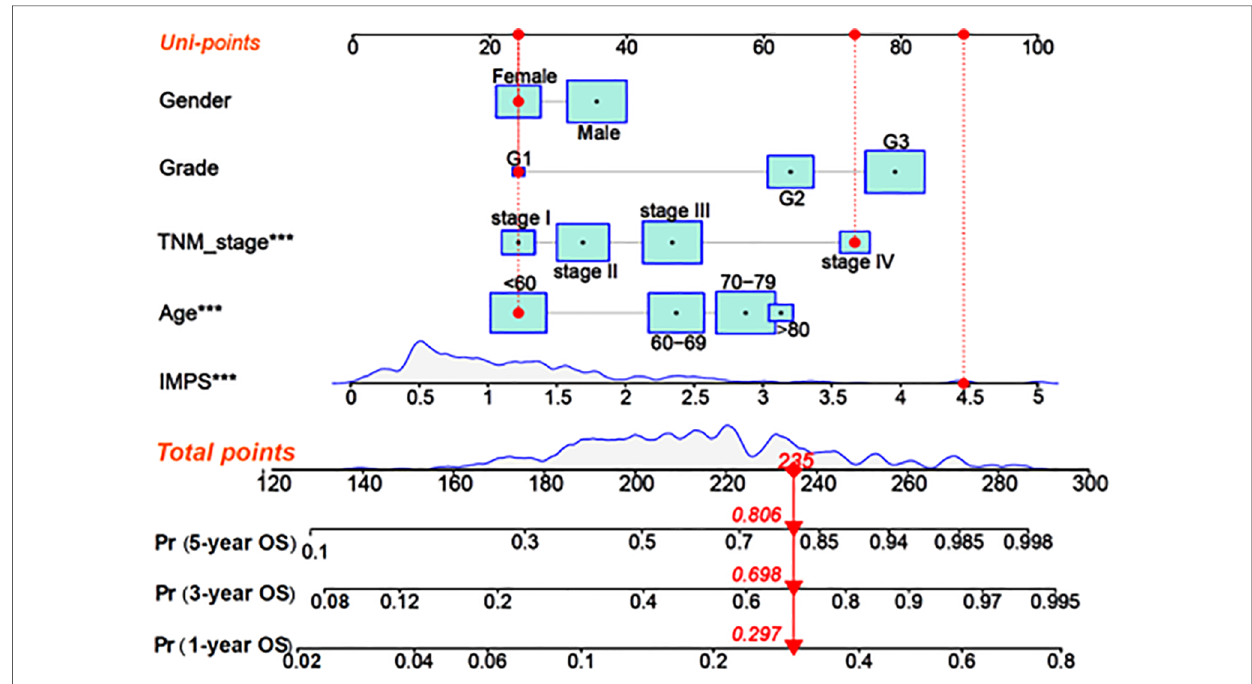
FIGURE 8 Construction of the combined nomogram based on IMPS and clinical characteristics. Nomogram combined IMPS and clinical characteristics for predicting 1-year, 2-year, and 3-year OS. The red dot presented a sample with each variable of the combined nomogram. The total point of the nomogram was calculated as the sum of each univariable risk points